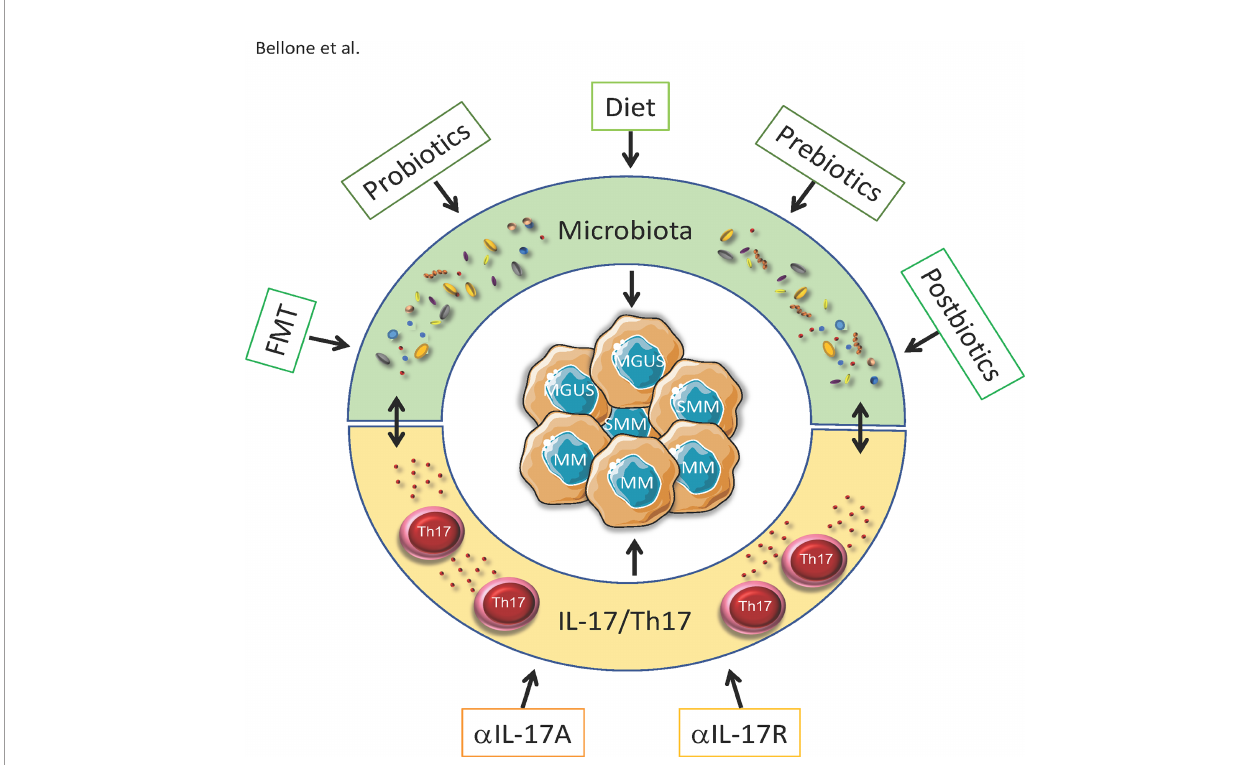
FIGURE 1 | Strategies to impact MGUS, SMM and MM by targeting microbiota and IL-17/Th17. Progression from asymptomatic MGUS and SMM to symptomatic MM partially depends on the microbiota-Th17 axis. Peculiar composition of the gut microbiota locally induces the differentation of Th17 cells, which migrates in the BM and supports disease progression. Strategies to impact the disease by targeting the microbiota include diets enriched of speci fi c nutrients(e.g.SCFA, vitamins, plant-speci fi c foods etc.) autologous or heterologous FMT, prebiotics probiotic bacteria and postibiotics. All these strategies indirectly also reduce IL-17/Th17 accumulating in the gut and in the BM. Other than through the microbiota, monoclonal antibodies againstIL-17 and Il-17R interfere with its pathway and prevent the progression from SMM to MM in